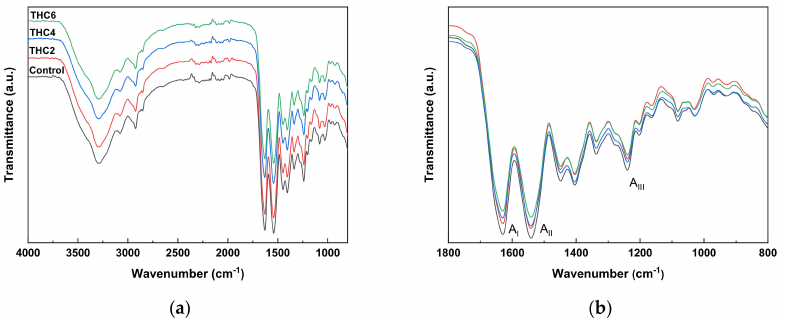
Figure 3. FTIR spectra of 3D-printed collagen scaffolds: ( a ) from 4000 to 750 cm − 1 ; and ( b ) from 1800 to 750 cm − 1